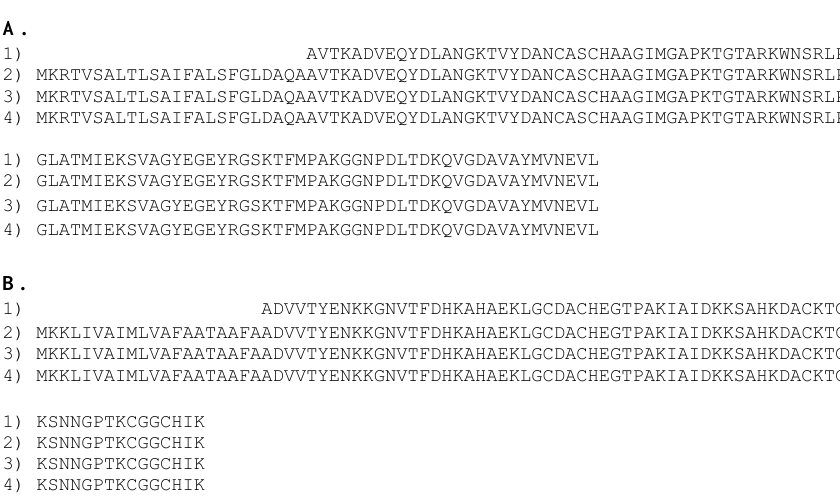
Figure 1. ( A ) Sequence alignment of cytochromes c5 from Prosthecochloris . (1) Van Beeumen et al. [5] soluble protein from 2-K mix, (2) translated genome from pure 2-K DSM 1685, (3) translated genome from N2 mix, and (4) translated genome from N3 mix. ( B ) Sequence alignment of cytochromes c-551.5 from Desulfuromonas. (1) Ambler [6] soluble protein from 2-K mix, (2) translated genome from pure 2-K DSM1675, (3) translated genome from pure N2 DSM1676, and (4) translated genome from N3 mix.